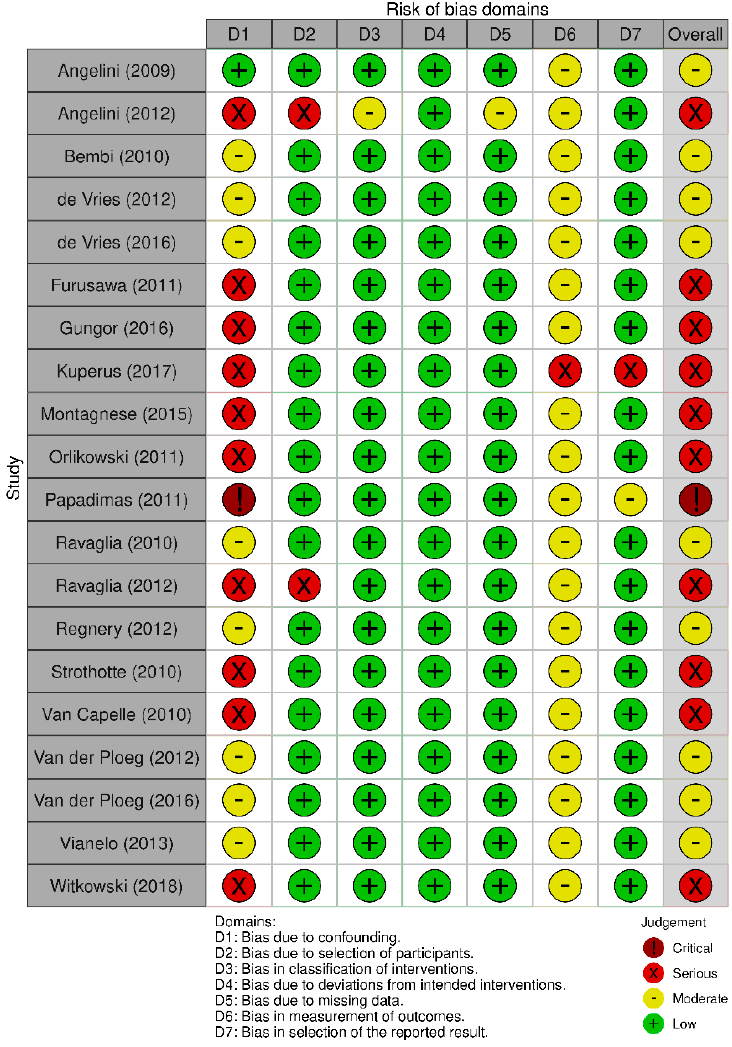
Figure 8. Risk of bias of included studies evaluated through the ROBIN-I tool.